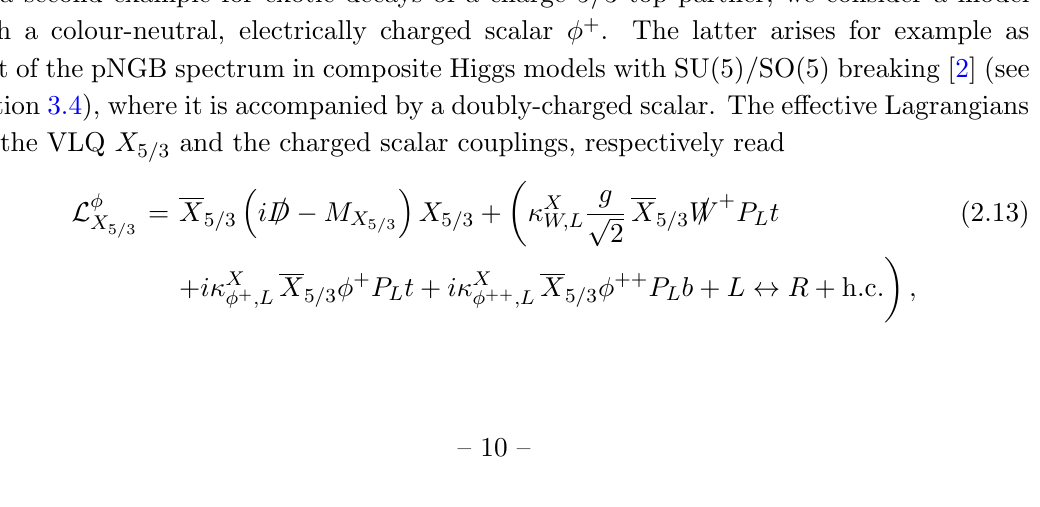
Figure 4 . Branching ratios of X model Bm3 introduced in section